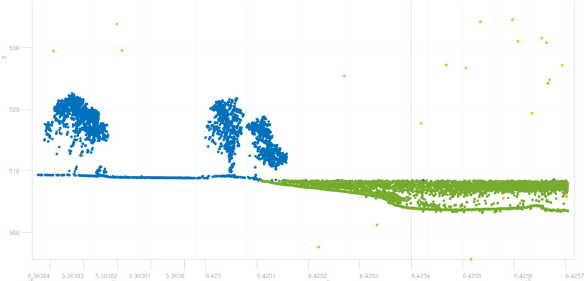
Figure 5. Section view of LiDAR point cloud of Autobahnsee (western shoreline). Points colored by intermediate classification into: point from above (blue) and below (green) the water surface and isolated points (brown) strips. The residual height error between the overlapping flight strips after strip adjustment, measured as DEM (Digital Eleva- tion Model) height differences at smooth bare land areas amount to 0.0 ± 0.06m (mean ± std.dev.) for the Autobahnsee sub-block. The LiDAR blocks of all other lakes resulted in similar deviations (no bias, std.dev. < 10cm). Due to high flight dynamics, time de-